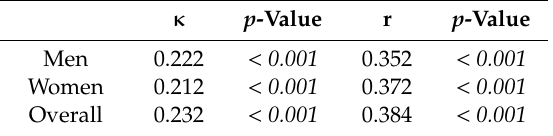
Table 2. The agreement and correlation between QUS and